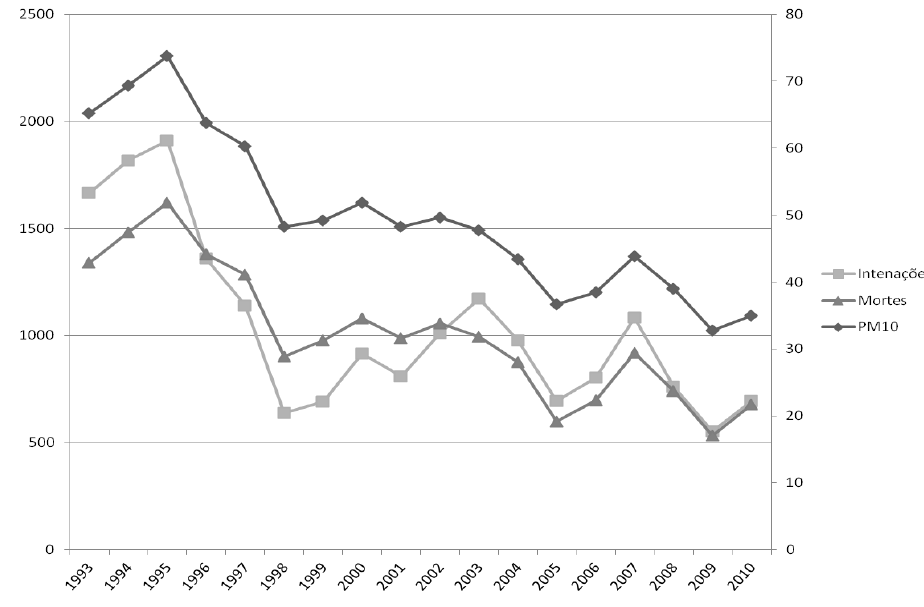
Figure 5. Number of hospitalizations and deaths of children and elderly individuals in Sao Paulo attributable to differences between measurement levels in average air pollution levels. The annual levels of PM and the standard of 20 μg/m 3 , proposed by the WHO and 10 used as